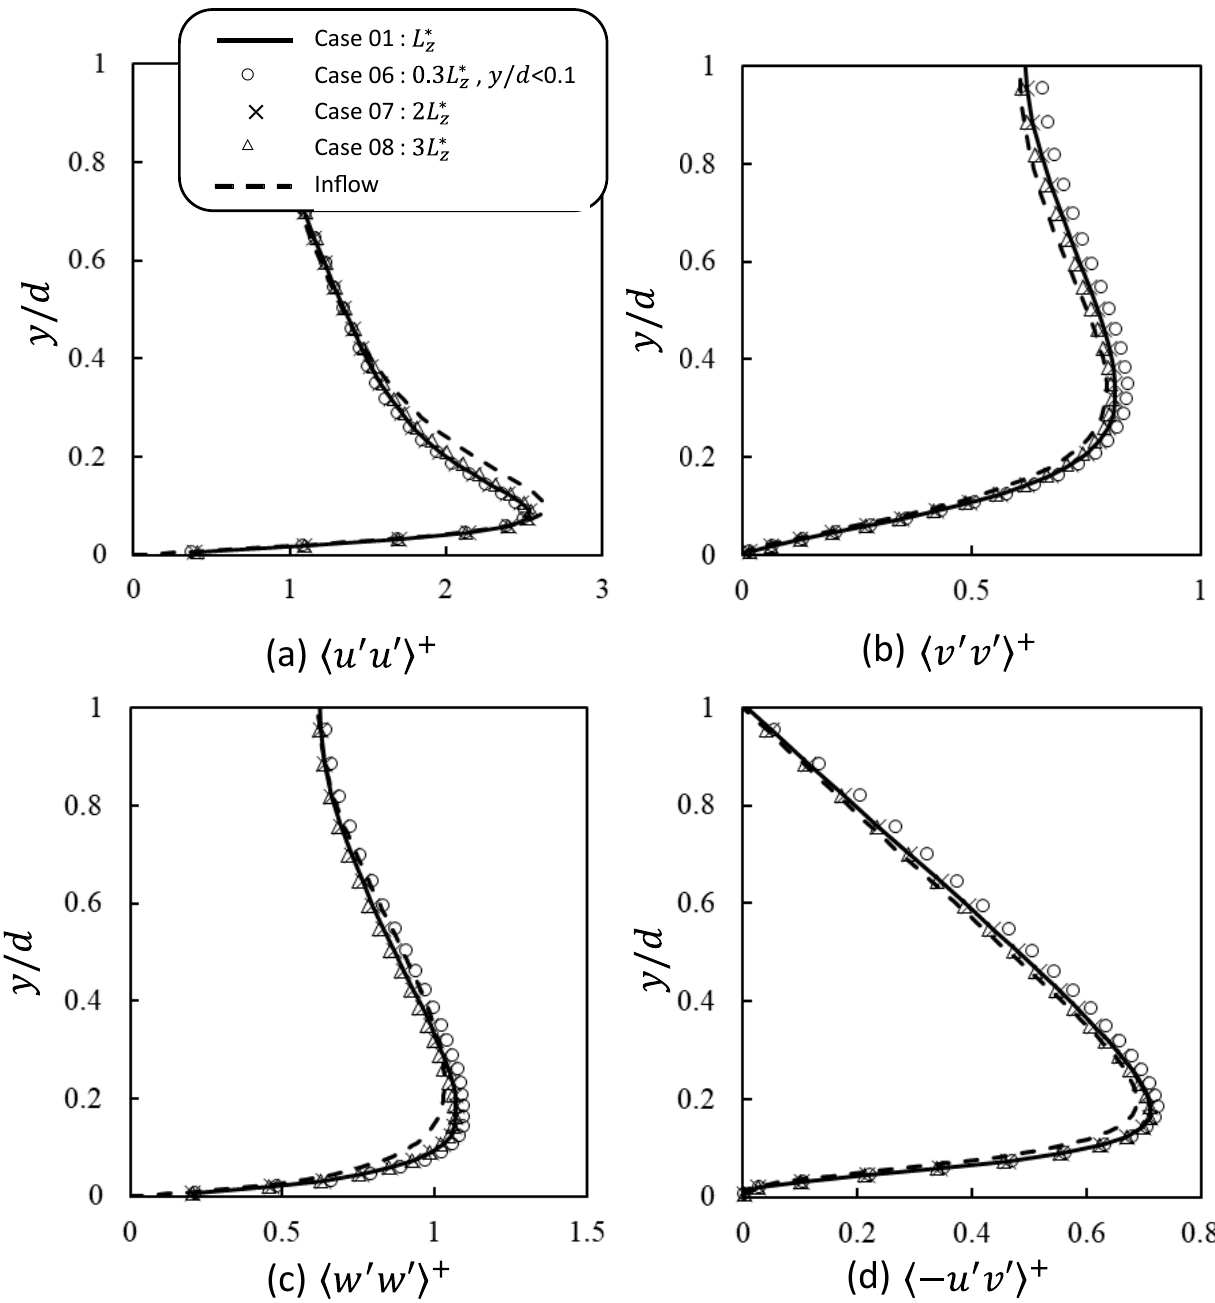
Figure 11. Mean and turbulent stress profiles at x / d = 50. In the figure, ( a ) (cid:104) u (cid:48) u (cid:48) (cid:105) + , ( b ) (cid:104) v (cid:48) v (cid:48) (cid:105) + , ( c ) (cid:104) w (cid:48) w (cid:48) (cid:105) + , ( d ) (cid:104)− u (cid:48) v (cid:48) (cid:105) +